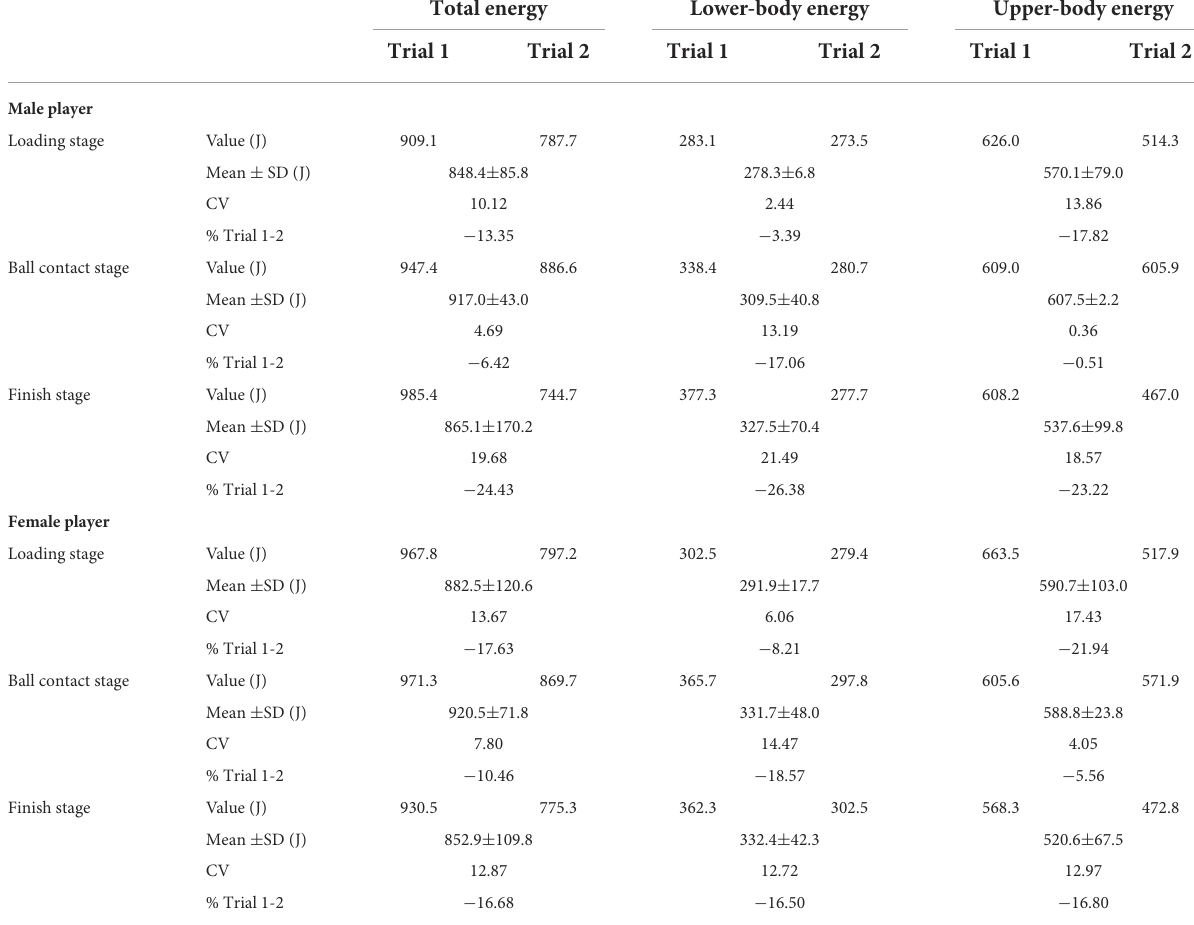
TABLE 1 Total and lower- to upper-body energetic transfer during tennis flat “first” serve stages for the male and female tennis